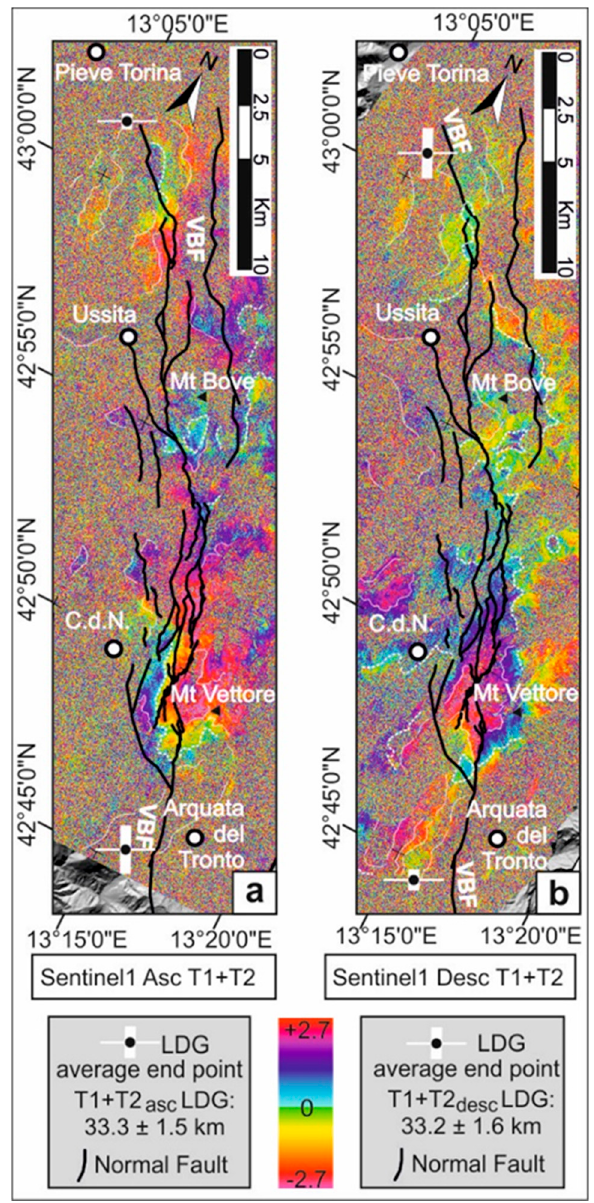
Figure 4. Same as Figure 3 but covering the entire period before the Mw 5.9 foreshock: T1+T2 period. ( a ) interferogram prepared from ascending orbit data between 27 August and 26 October, ( b ) interferogram prepared from descending orbit data between 2 September and 26